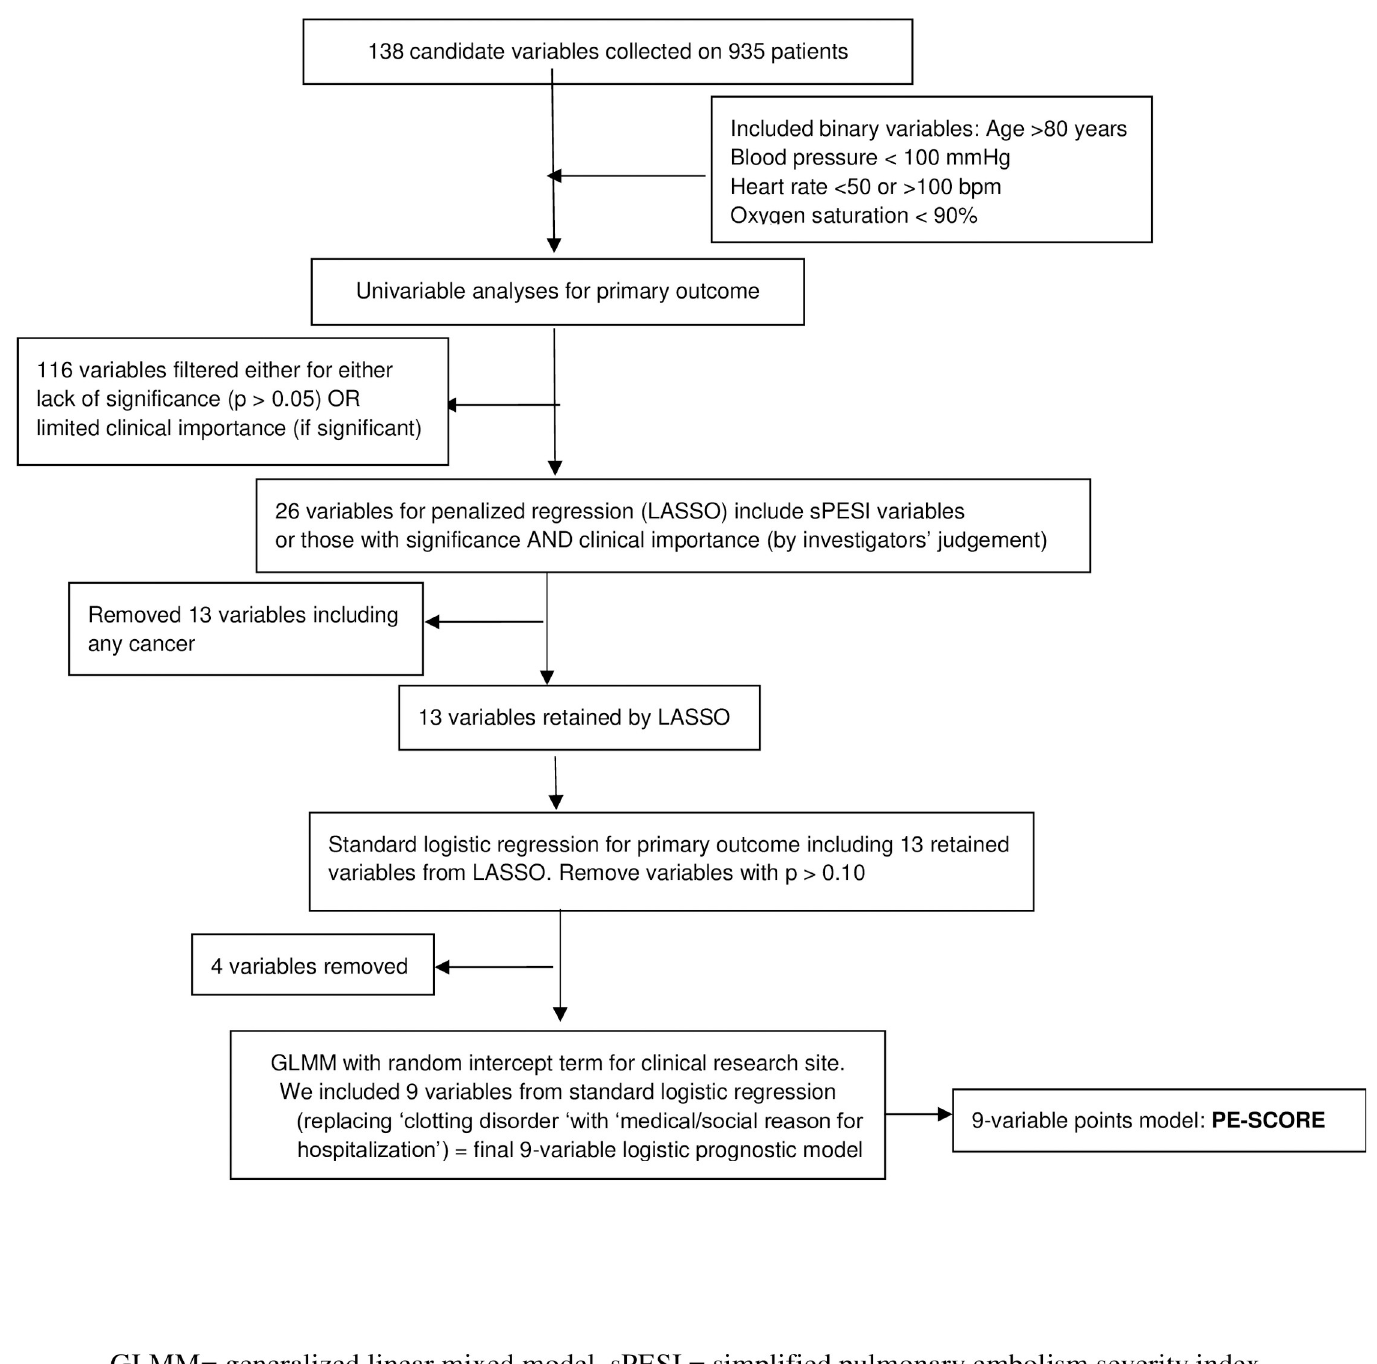
Fig 1. Deriving the nine-variable prognostic